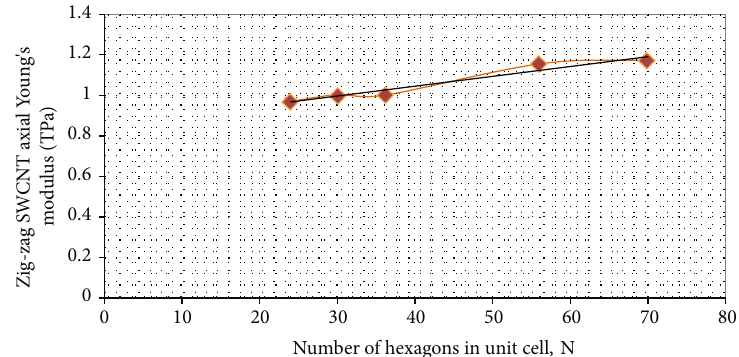
Figure 11: The in fl uence of the number of hexagons in unit cell on zig-zag SWCNT axial Young ’ s modulus.